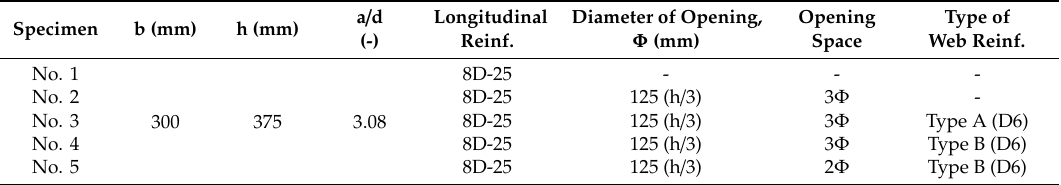
Table 3. Properties of